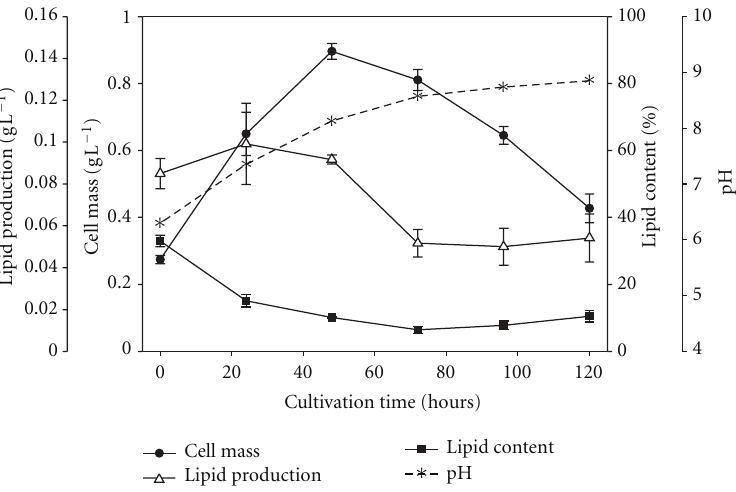
Figure 2: Cell mass production, lipid production, and lipid content of R. glutinis during cultivation on wastewaters from potato processing.